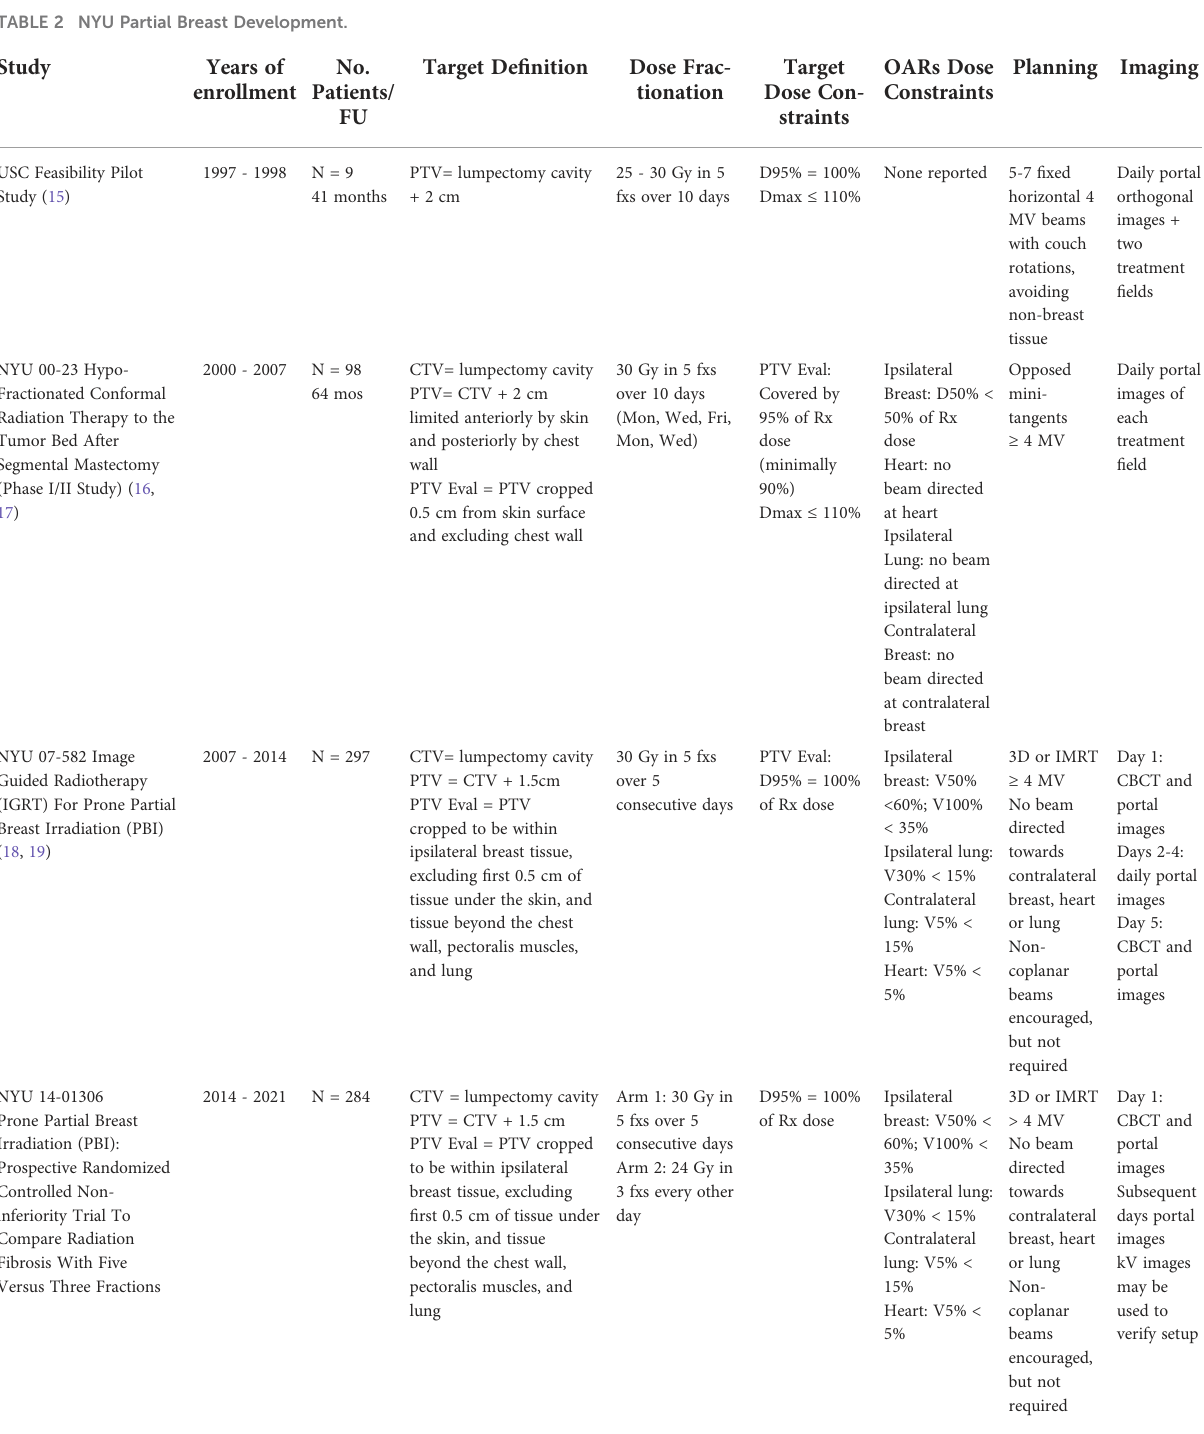
TABLE 2 NYU Partial Breast